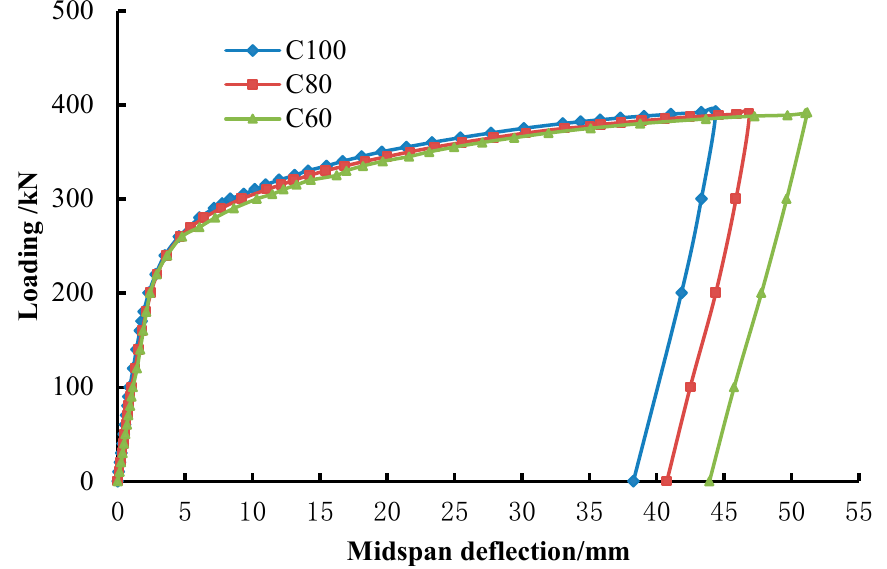
Figure 8. Comparison of three different specimens’ P– ω curves.